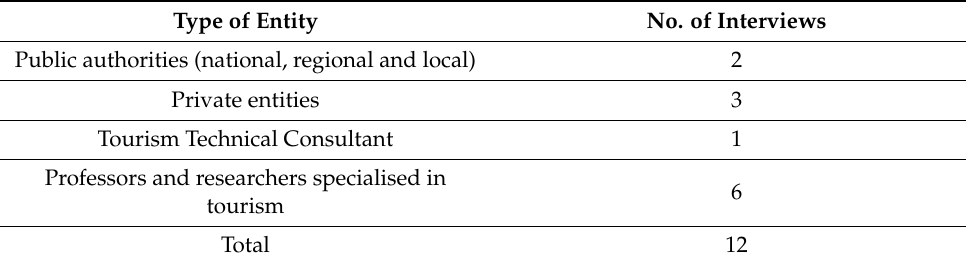
Table 2. Participants of the exploratory interviews. Source: Own realisation. Type of Entity No. of